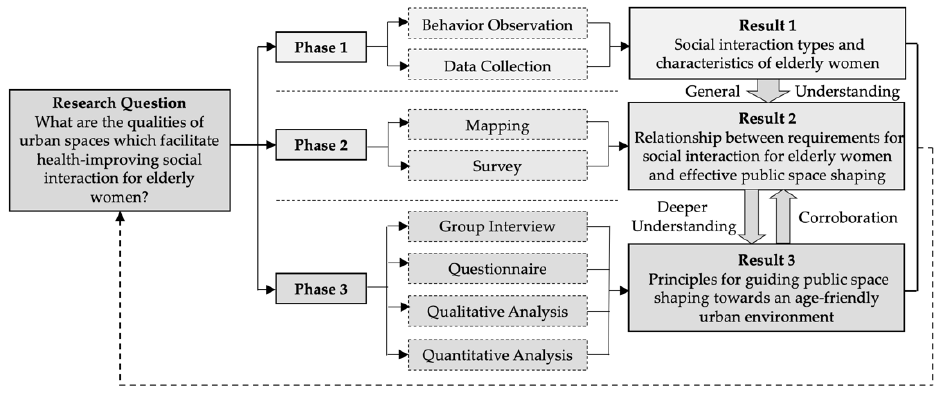
Figure 2. Methodological framework.